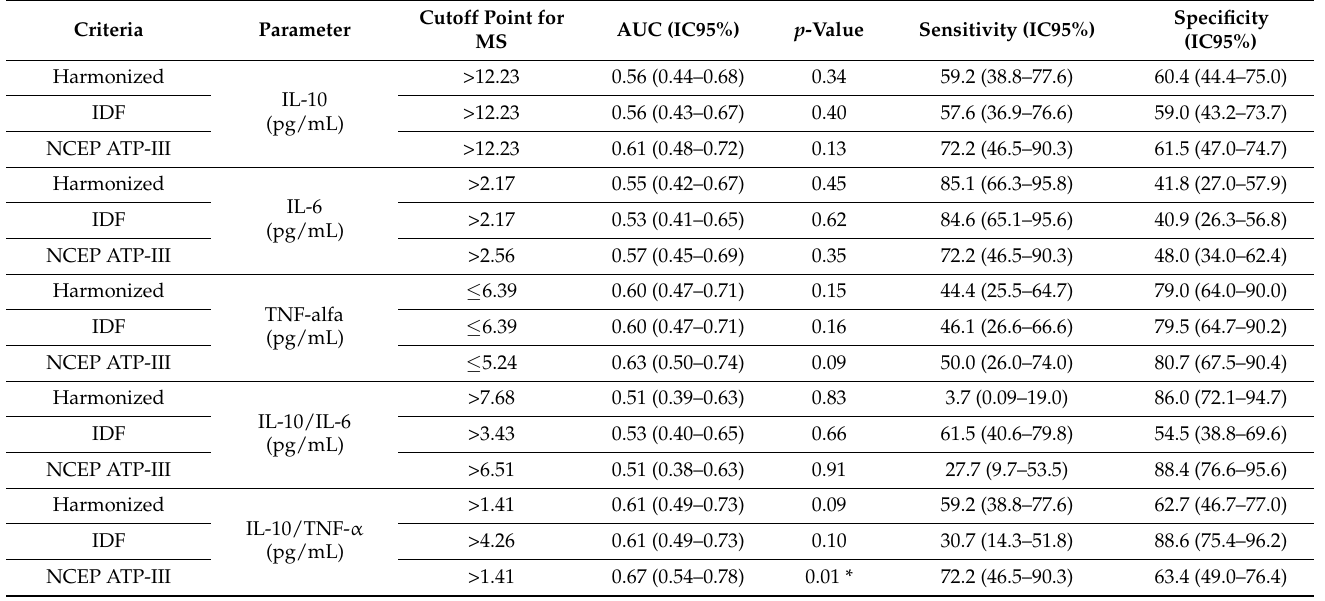
Table 3. Analysis of the performance of cutoff points for IL-10, IL-6, TNF- α , IL-10/IL-6, and IL- 10/TNF- α for the diagnosis of metabolic syndrome by different diagnostic criteria.